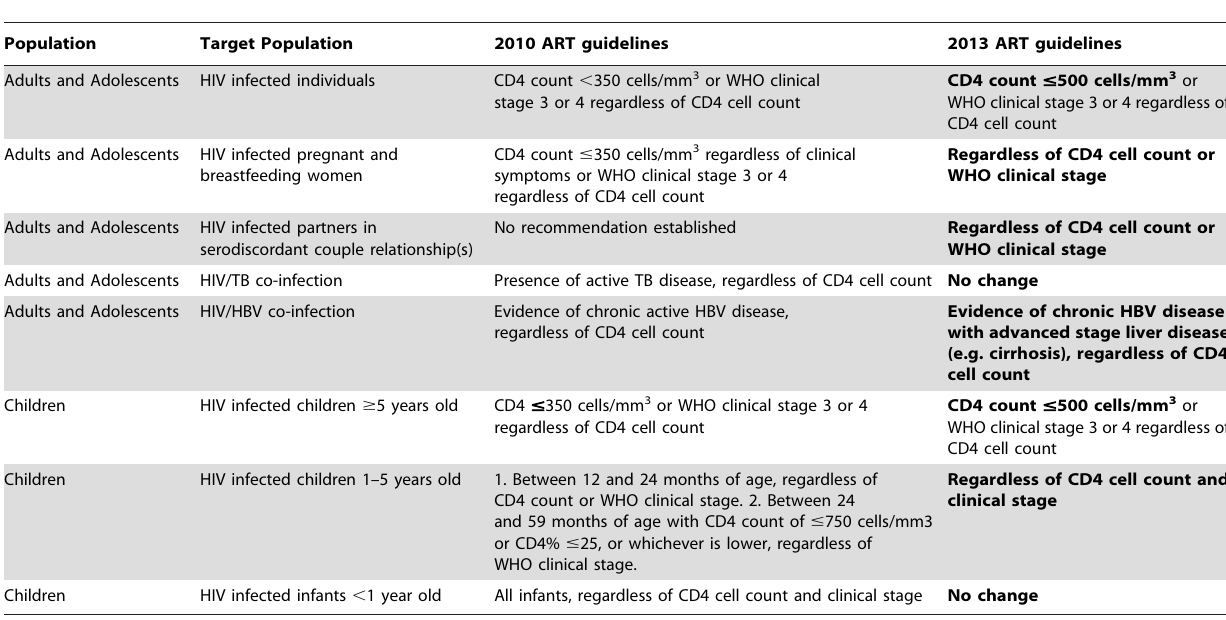
Table 1. Comparison of WHO guidelines for ART initiation among people living with HIV in the year 2010 and 2013.